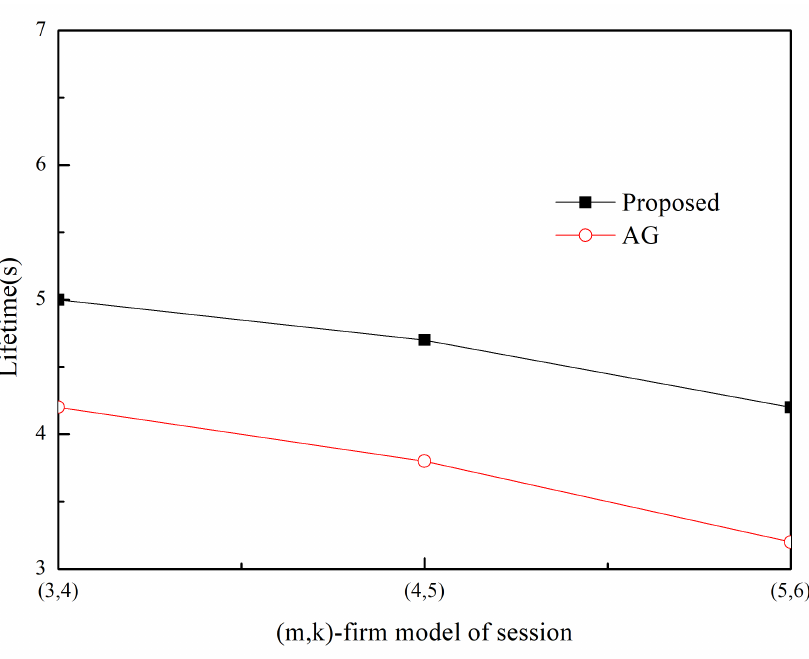
Figure 9. Lifetime in (2,3)-firm application as a function of ( m , k )-firm